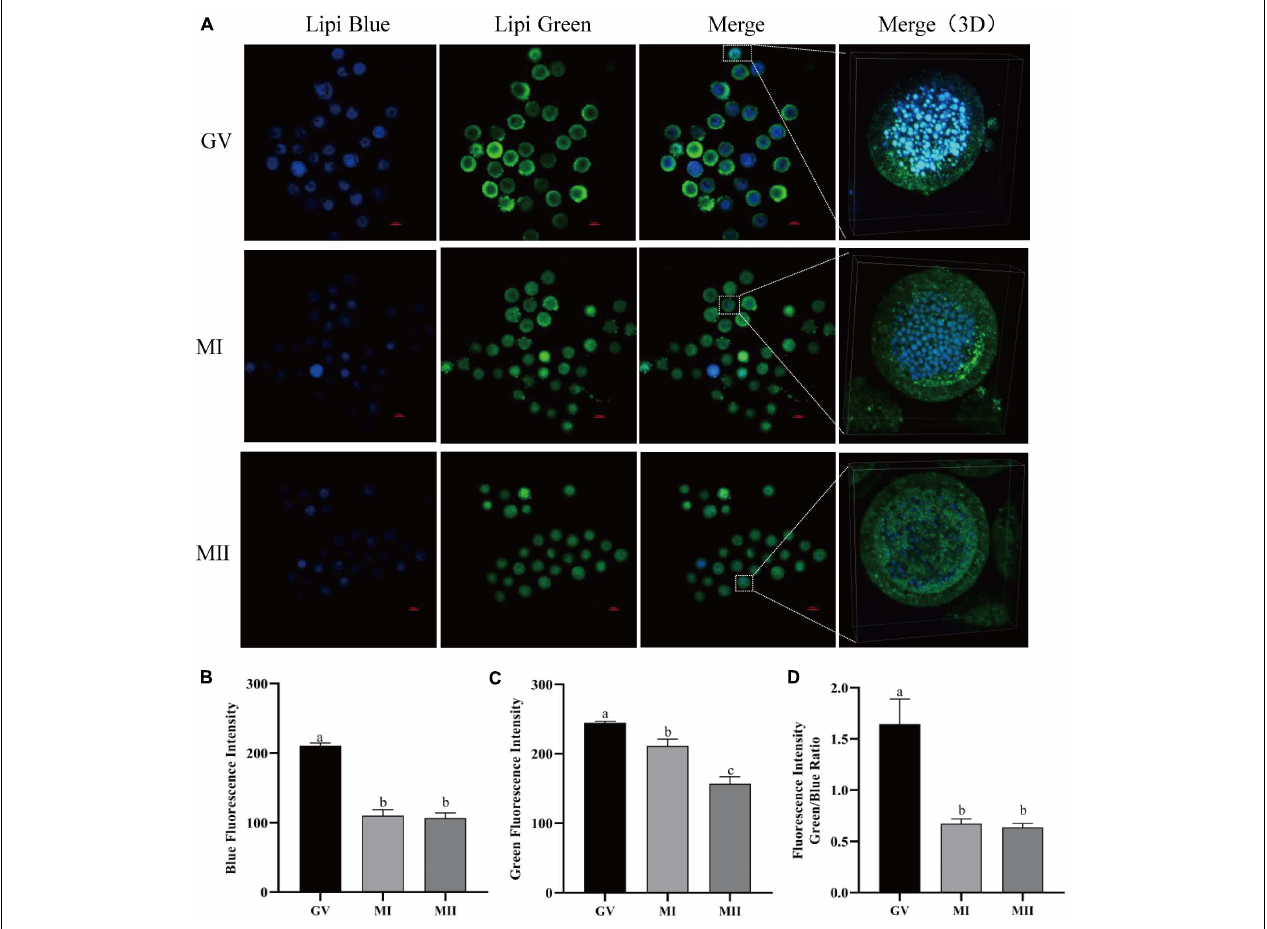
FIGURE 1 | The dynamics of LDs in pig oocytes during in vitro maturation. (A) Representative images of Lipi-Blue fluorescence (blue) and Lipi-Green fluorescence (green) in germinal vesicle (GV)-, MI-, and MII-stage oocytes. Scale bar: 100 µ m. (B) Quantification of fluorescence intensity of Lipi-Blue in GV- ( n = 31), MI- ( n = 41), and MII-stage ( n = 44) oocytes. (C) Quantification of fluorescence intensity of Lipi-Green in GV- ( n = 30), MI- ( n = 37), and MII-stage ( n = 43) oocytes. (D) Ratio of fluorescence intensity of Lipi-Blue and Lipi-Green in GV- ( n = 45), MI- ( n = 64), and MII-stage ( n = 56) oocytes. Student’s t -test and one-way ANOVA were utilized for statistical analyses. Different lowercase letters indicate significant differences. Error bars indicate SEM.